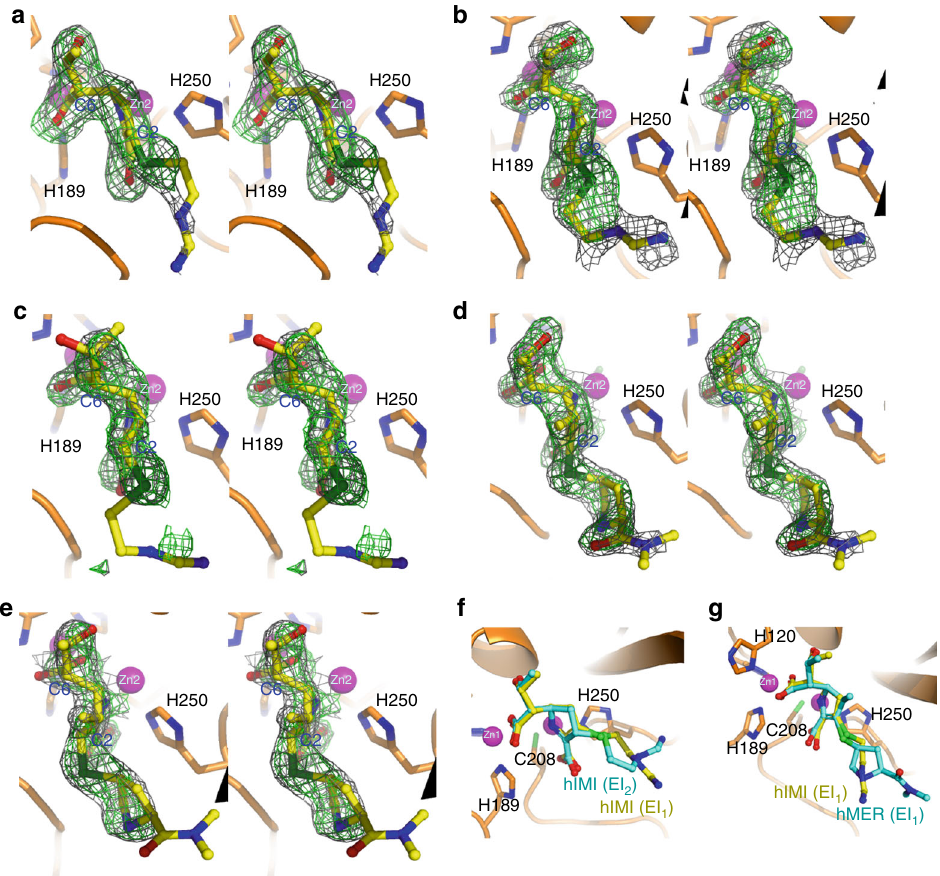
Fig. 2 Imipenem and meropenem intermediates bound to the active site of NDM-1. a – e Stereo views of the Δ 2 isomer of hydrolyzed imipenem ( a ), or meropenem ( d ), in EI 1 , the Δ 1 isomer of hydrolyzed imipenem ( b ), or meropenem ( e ), in EI 2 , and the Δ 1 isomer of hydrolyzed imipenem in EP ( c ), represented as ball-and-stick models. The 2 F o – F c electron density shown as gray mesh is contoured at 1.0 σ and the omit F o – F c electron density shown as green mesh is contoured at 3.0 σ . f Overlay of hydrolyzed imipenem in EI 1 and EI 2 . g Overlay of hydrolyzed imipenem and meropenem in EI 1 . Zinc ions are represented by magenta spheres in all